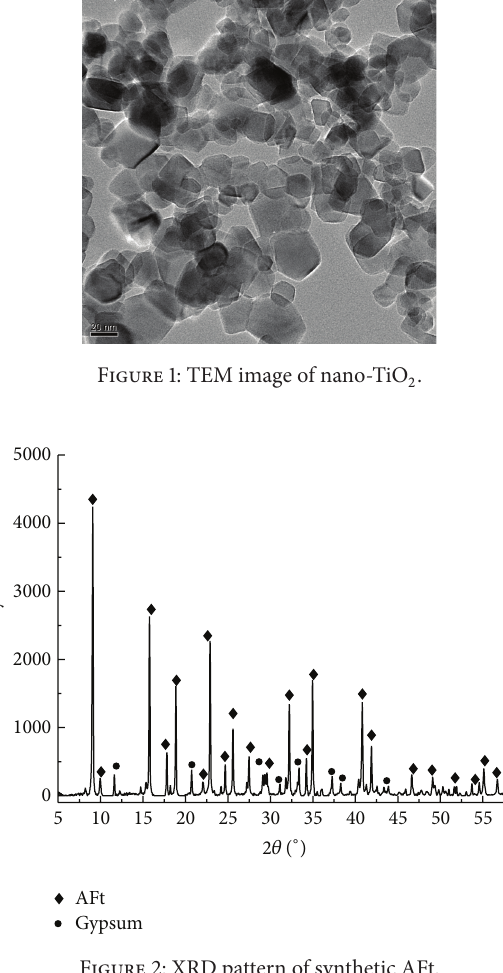
Figure 2: XRD pattern of synthetic